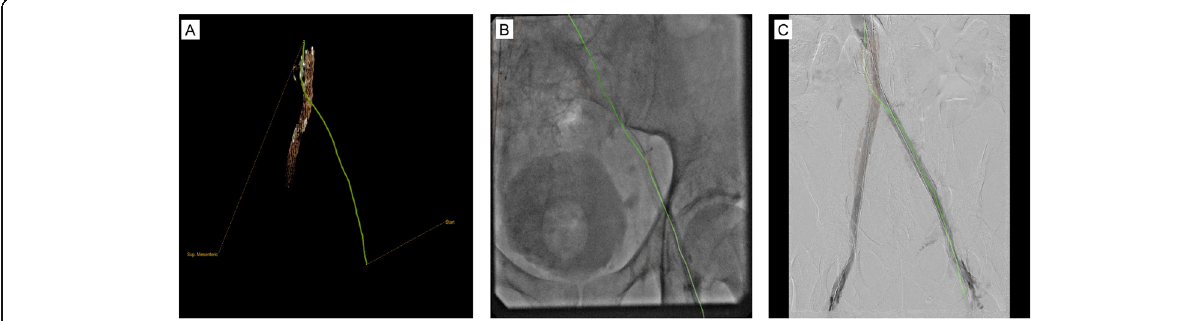
Fig. 4 Cohort patient number 6 with a right iliac vein stent that was used for initial registration instead of the bones ( a ). The registration accuracy was considered appropriate ( b ). Final DSA under large field of view showed complete recanalization and allowed final assessment of the registration accuracy ( c